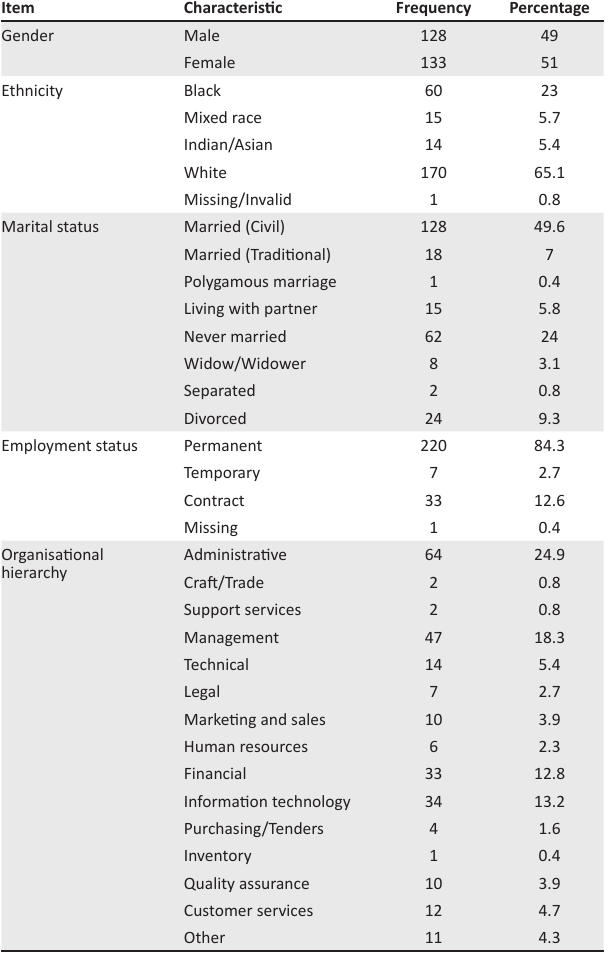
TABLE 1: Demographic characteristics of participants.